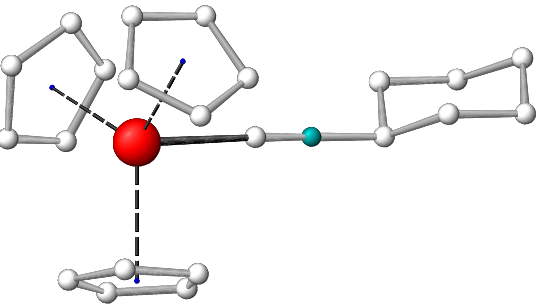
Figure 1. Arrangement of the ligands in the (Cp) 3 M(C ≡ NCy) complexes. C atom in grey, metal in red, N in blue green and H atoms omitted for reasons of clarity.